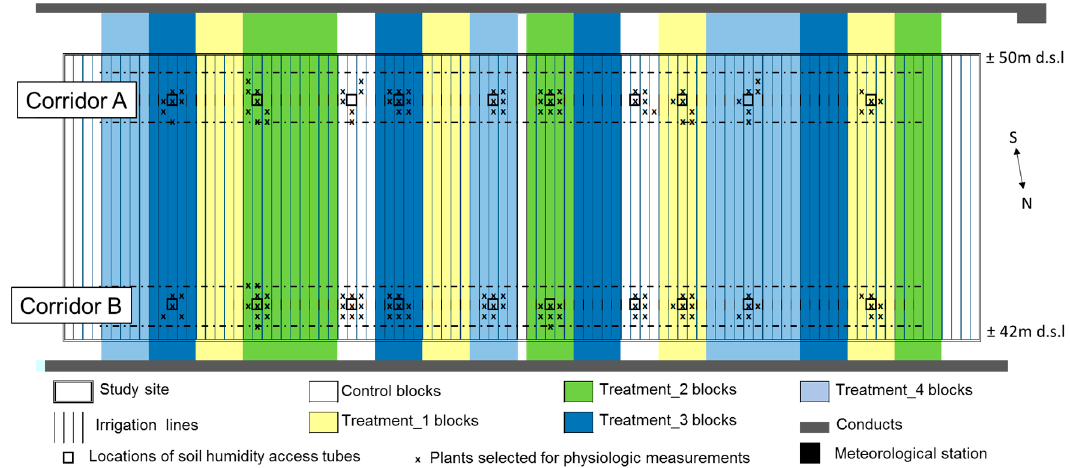
Figure 1. Schematic figure of the experimental plot.